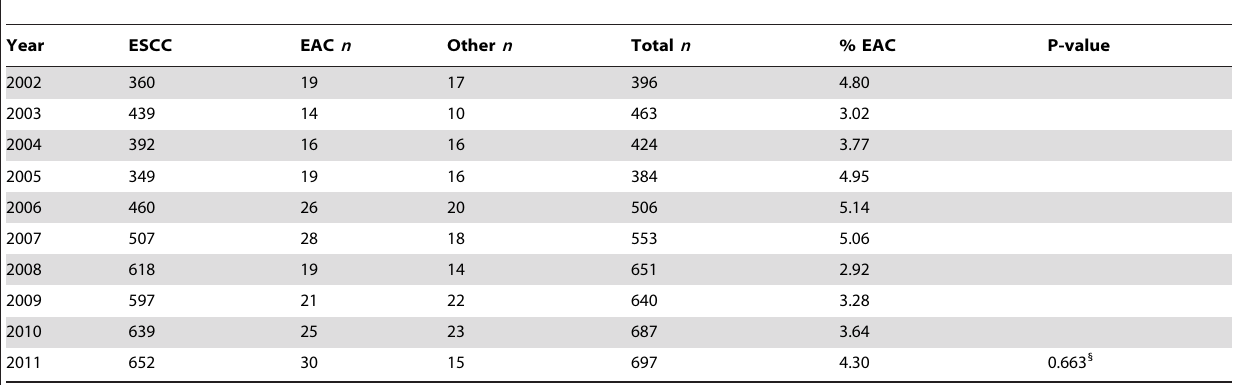
Table 2. Distribution of esophageal squamous cell carcinoma (ESCC) and esophageal adenocarcinoma (EAC) by